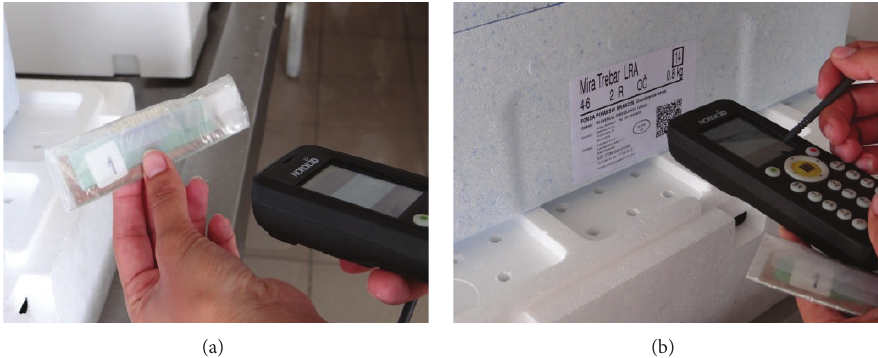
Figure 5: RFID-TL (a) is identified; and (b) aggregated with the box.